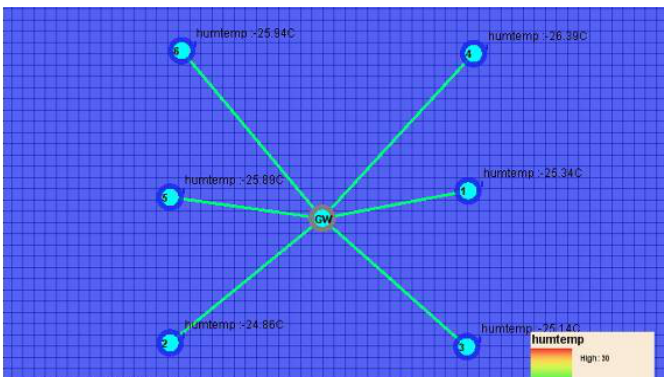
Figure 2. Topological structure of the